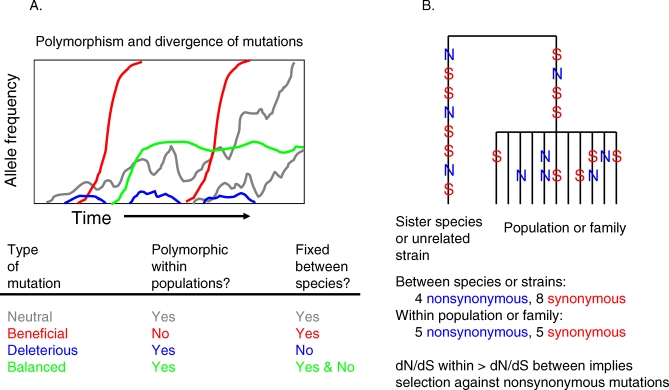
Patterns of Polymorphism for Mutations of Different Effects(A) A graph illustrating general trajectories of neutral, advantageous, deleterious, and balanced mutations. Below is a table listing the likelihood of observing these mutations as polymorphisms in a sample from within a population, or as fixed differences between species. Note that neutral, advantageous, and deleterious mutations make clearly distinct predictions.(B) An example of a McDonald-Kreitman test using the counts of nonsynonymous (N) and synonymous (S) mutations within and between species, or lineages of a pedigree. In the data shown, the dN/dS ratio is higher within species than between species, a pattern seen in many mtDNA data sets, and in the mutator mouse pedigree study reported by Stewart et al.